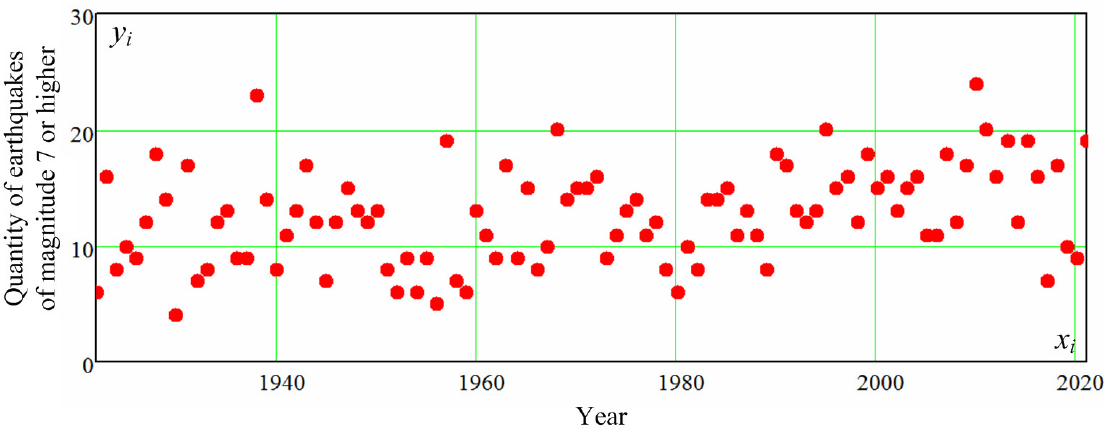
Table 5 contains data observed from 1922 to 2021, where i is the number of observations, X is the year, and Y is the quantity of earthquakes. Figure 7 shows the graphical view of the dataset.